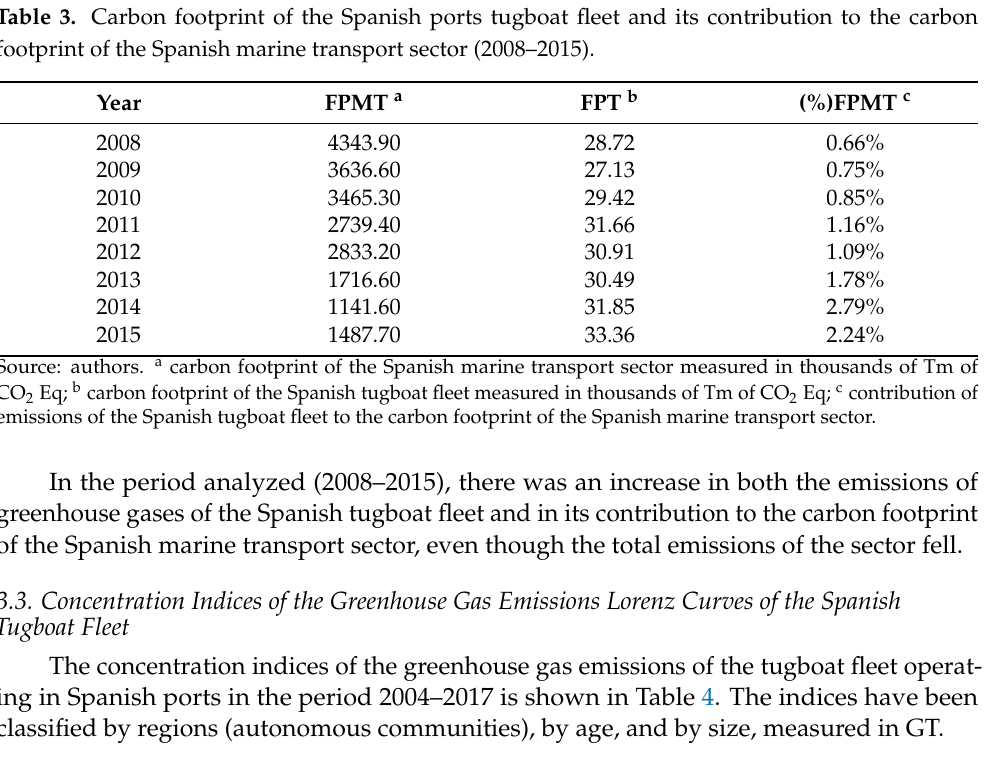
Table 4. Concentration indices of the greenhouse gas emissions of the Spanish tugboat